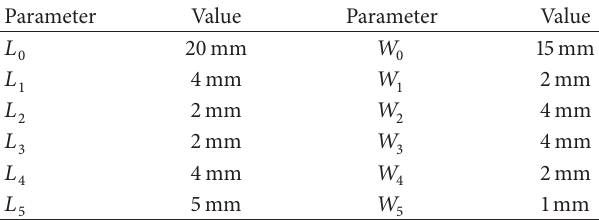
Table 1: Configuration of the proposed patch antenna.